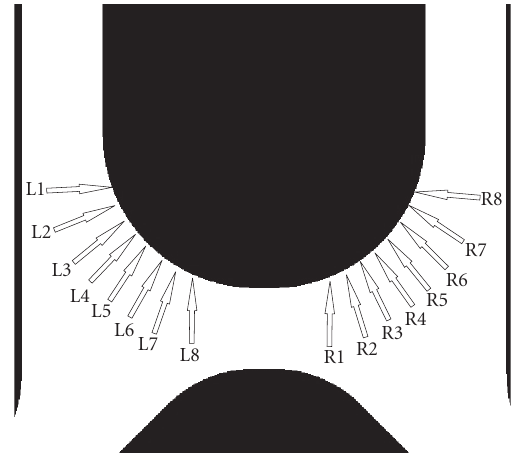
Figure 7: Labeled points on the left and the right impingement points in the WSS